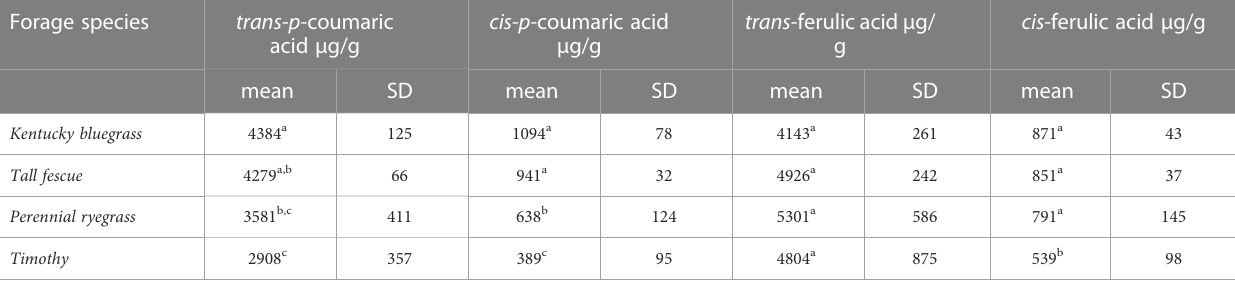
TABLE 2 Monomeric ester-linked phenolic acids in water-insoluble cell wall material isolated from leaf tissue of cool-season forage species. Forage